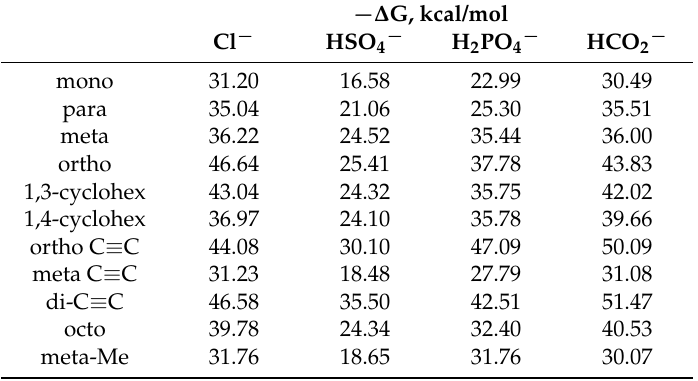
Table 6. Binding free energies (kcal/mol) at 25 C for pairing of indicated Lewis acids with anions. − ∆ G, kcal/mol Cl